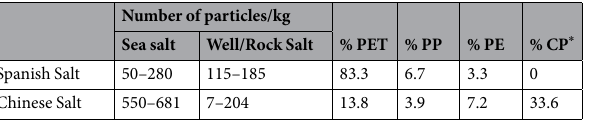
Number of particles/kg